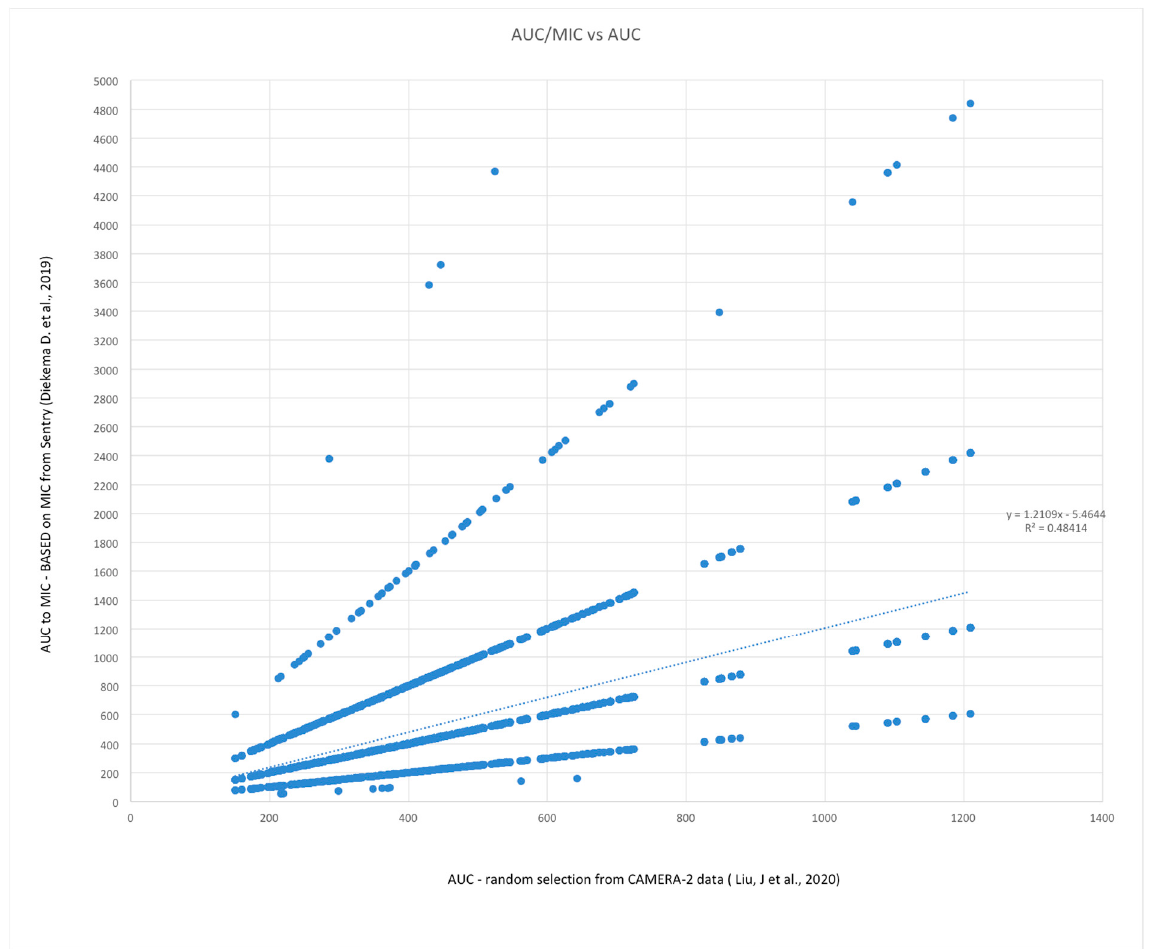
24 :MIC number, ( percentage of to-